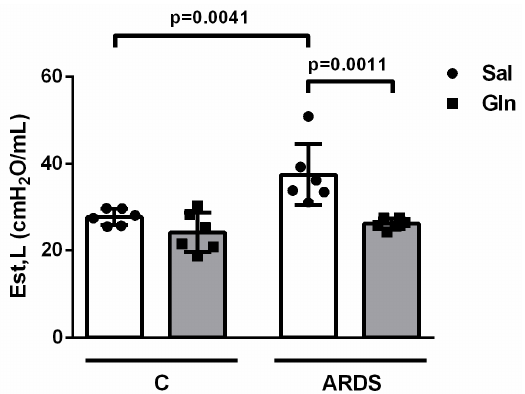
Figure 4. Glutamine reduced lung functional impairment in a mouse model of pulmonary ARDS. Twenty-four hours after ARDS induction, mice were sedated, anesthetized, tracheotomized, paralyzed, and ventilated in constant-flow mode in an open chest preparation. Static lung elastance (Est,L) was measured by the end-inflation occlusion method (10 respiratory cycles / animal). Values in cmH 2 O / mL are expressed as mean ± SD of six animals in each group. Symbols represent individual animals. Experiments were performed in triplicate. The data shown are from a single representative